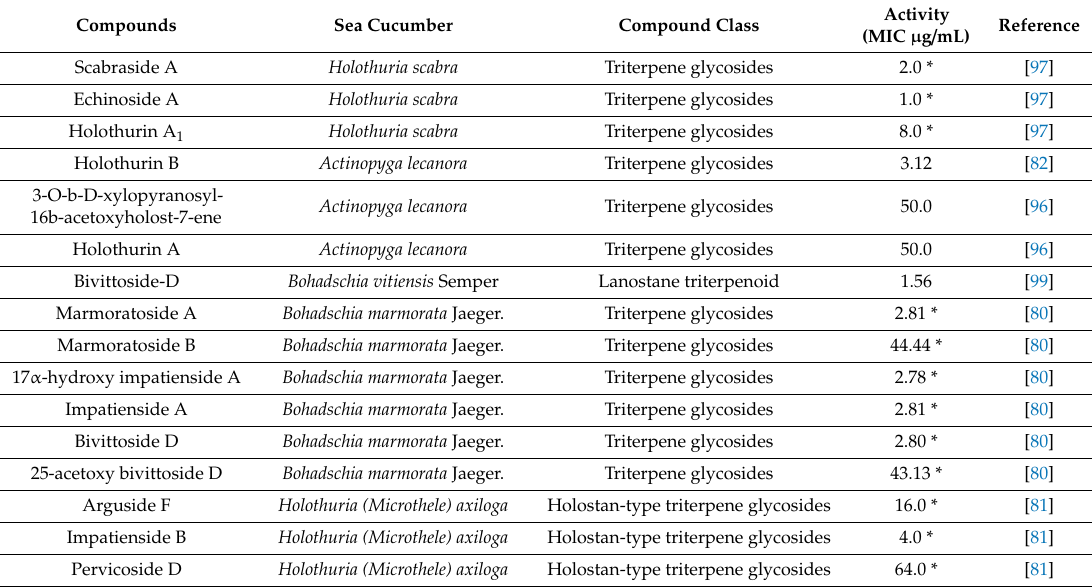
Figure 4. Chemical structure of compounds from sea cucumbers with e ff ective antifungal activities against A. fumigatus . ( a ) Impatienside B, ( b ) Marmoratoside A (1); 17 α -hydroxy impatienside (2); Impatienside A (3); & Bivittoside D (4), and ( c ) Holothurin B. Table 5. Characterized compounds against A. fumigatus from sea